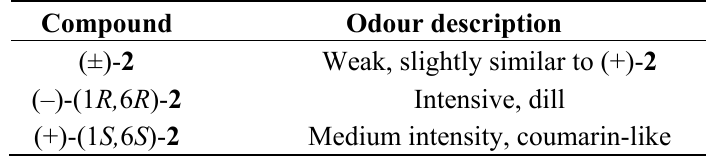
Table 1. Odoriferous characteristics of lactones